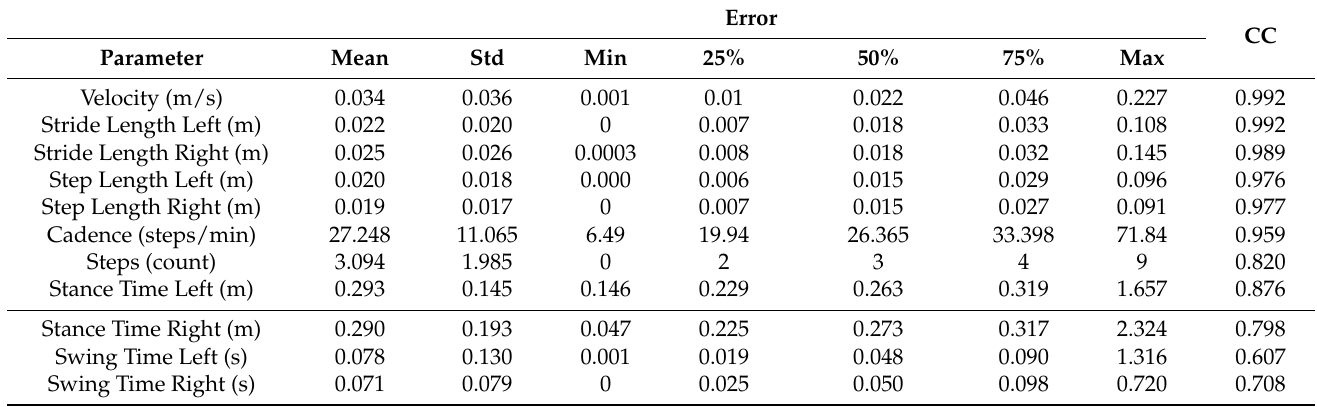
Table 3. Error metrics of the gait parameters calculated by the aTUG chair compared to GAITRite ® using the Pearson correlation coefficient.